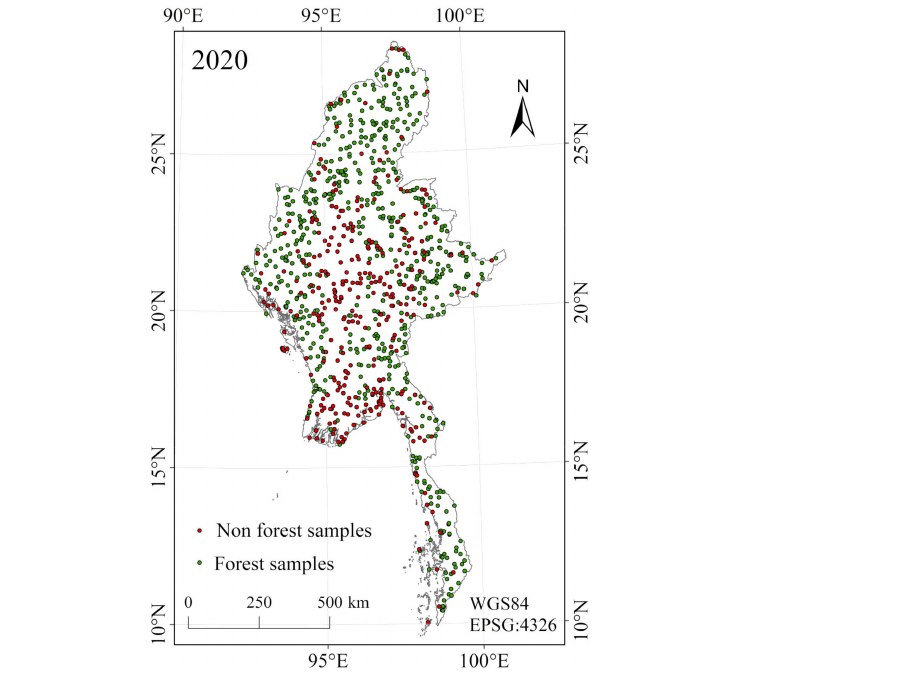
Figure 1. Spatial distribution of forest and non-forest validation samples in Myanmar (2020). To analyze the driving factors for spatial consistency from the aspects of terrain and climate, we chose (1) the Digital Elevation Model (DEM) data with 30 m resolution from Shuttle Radar Topography Mission (SRTM) [32,33] and calculated the slope data based on it; (2) KÖPPEN-Geiger climate classification [34] scheme includes six climate zones in Myanmar (Figure 2): Tropical Monsoon Climate (Am), Tropical Savanna Climate (Aw), Humid Subtropical Climate (Cwa), Subtropical Highland Climate (Cwb), Sub-boreal Monsoon Climate (Dwc) and Boreal Tundra Climate (ET).